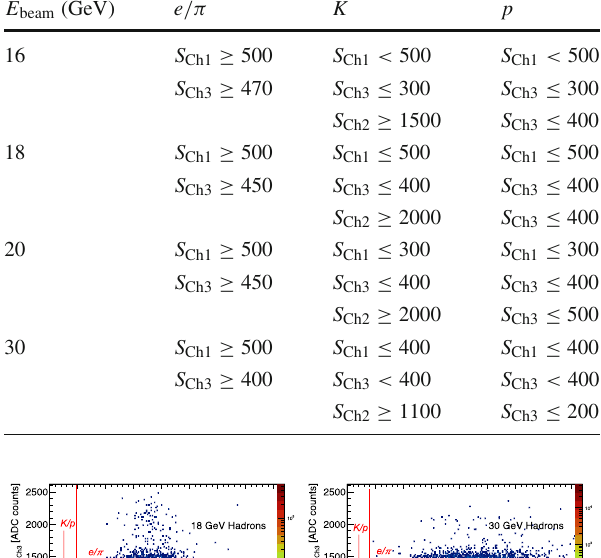
Table 3 Selection criteria in S Ch1 , S Ch2 and S Ch3 signals applied to identify e /π , K and p event samples for the four particle beam energy data sets. The Cherenkov signals are measured in ADC counts